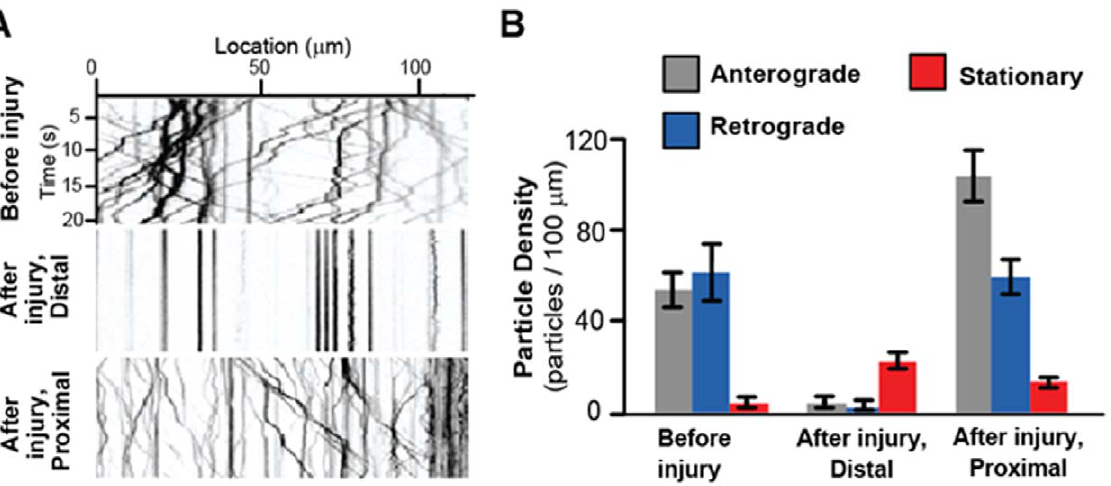
Figure 3. Changes in axonal transport after nerve-crush injury. (A) Kymographs from example movies of ANF-GFP labeled vesicles in an uninjured axon (Movie S3), the distal stump 3 hours after injury (Movie S4) and the proximal stump (Movie S5) 3 hours after injury. (B) Particle density (anterograde, retrograde, and stationary) was quantified per 100 m m of axon length. In the proximal stump 3 hours after injury, there was a 90% increase in anterograde particle density (p-value=0.03, n=16), but no significant change in retrograde particle density (p-value , 0.01, n=16). In contrast, transport was almost completely halted in the distal stump (p value , 0.01, n=8). Error bars represent standard error of the mean.